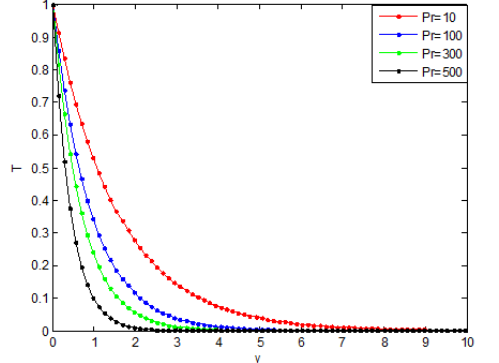
Figure 13. Effects of Prandtl number on temperature profile